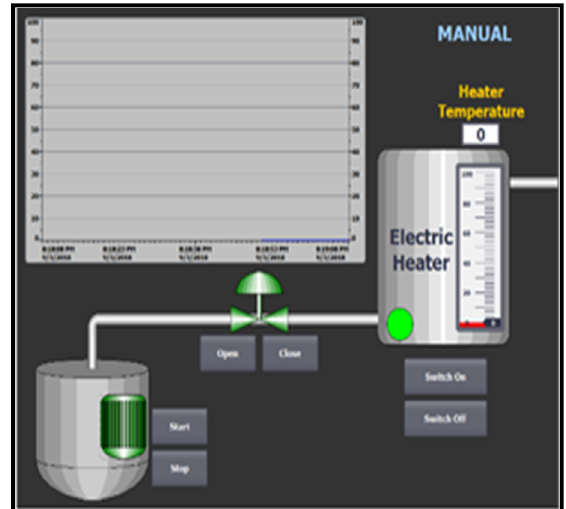
Fig. 6.b The MANUAL mode.